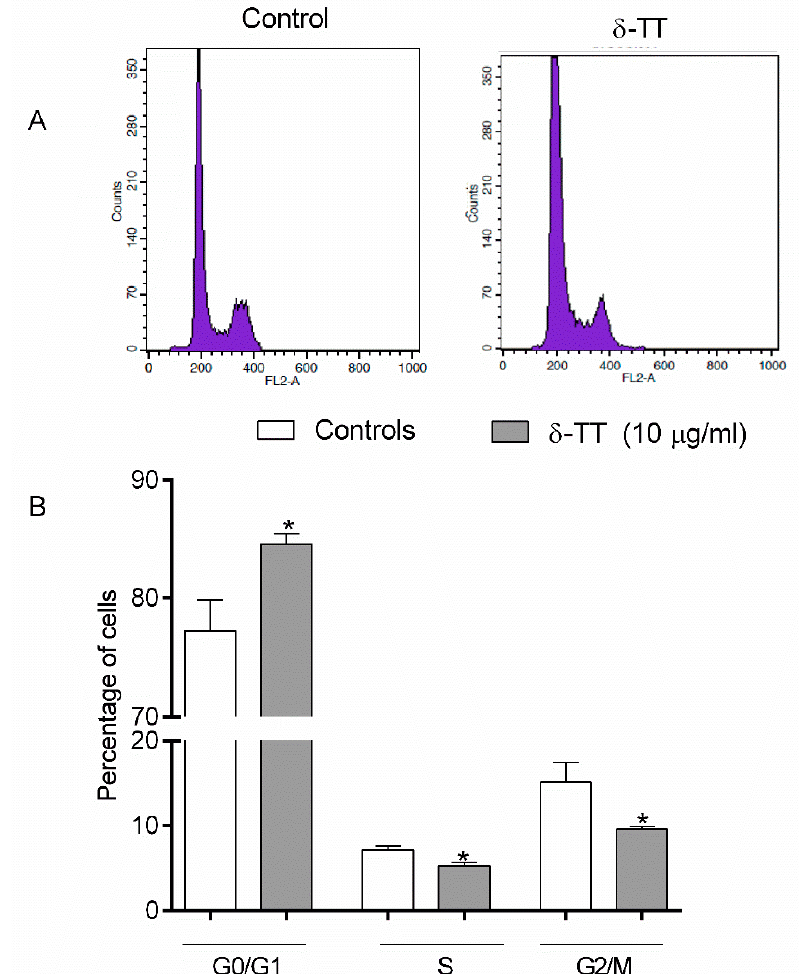
Figure 1. E ff ects of δ -TT (10 µ g / mL) on the di ff erent cell cycle phases in MC3T3-E1 cells after 24 h of incubation. The values are the percentage of cells in each phase, as determined by the FACScalibur flow cytometer. ( A ) representative FACS analysis images; ( B ) Quantification of cell cycle distribution. The bars represent the mean ± SEM of six replicates within a single experiment. * p < 0.05 vs. controls.